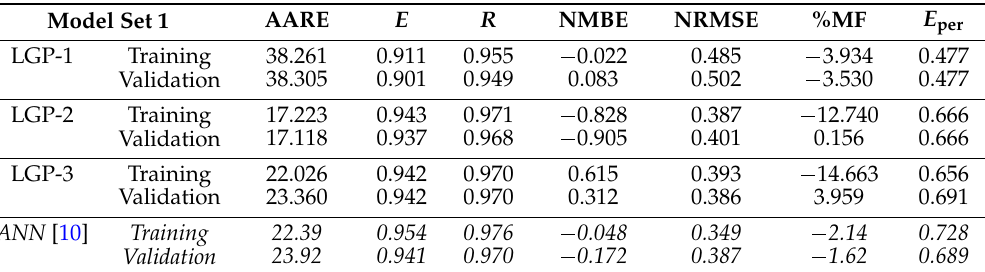
Table 5. Statistical measures for LGP standalone application.